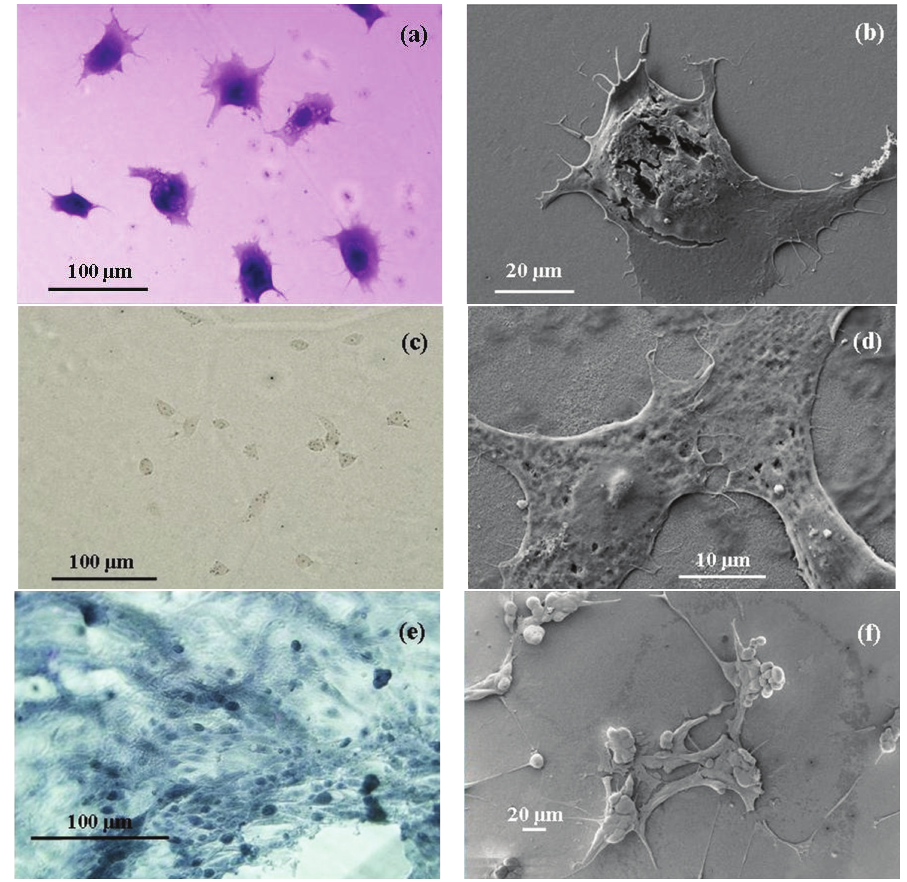
Figure 3: Optical (left) and field emission scanning electron microscopy (right) images of Cos-7 (a, b), Vero (c, d), and Madin-Darby Canine Kidney (e, f) cell lines showing attachment to the electrochemically engineered Anodic Aluminium Oxide membrane. (Images taken by Murdoch Applied Nanotechnology Research